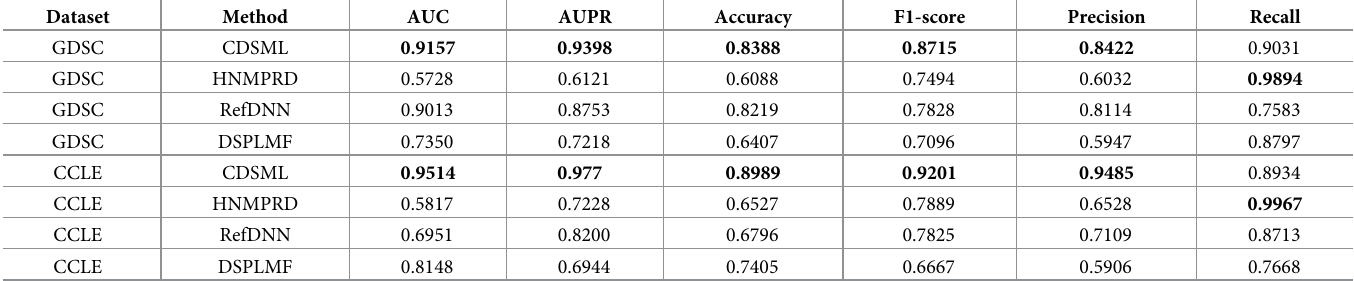
Table 6. Comparison of CDSML’s performance with state-of-the-art classification methods’ performance on GDSC and CCLE. The assessments were done by averag- ing 30 repetitions of stratified five-fold cross-validation. The highest value of each criterion is shown in bold. Dataset